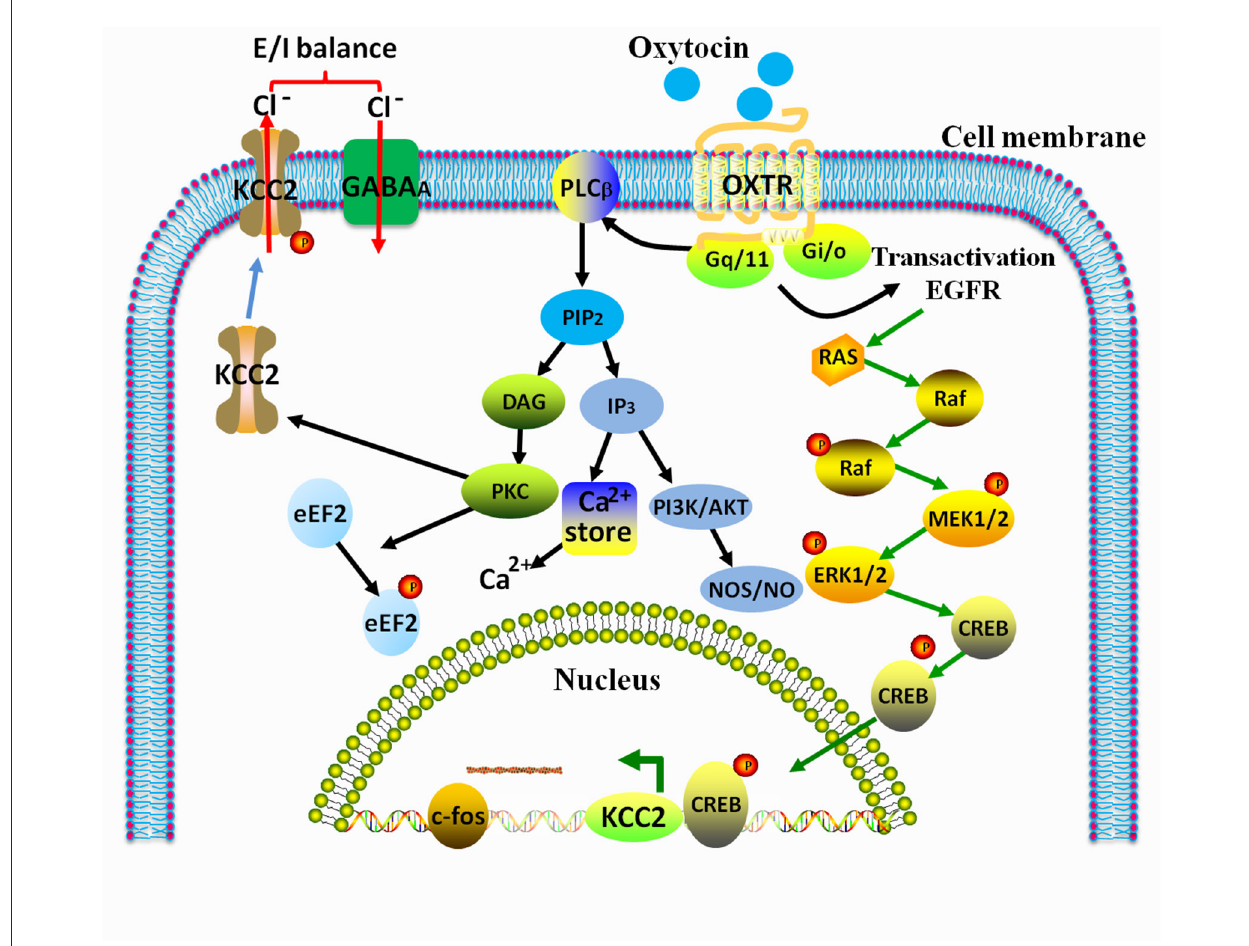
FIGURE4 Relevant signaling pathways of OXT/OXTR in the central nervous system regulate gene transcription and expression and induce LTP, E/I balance, and behavioral responses (Busnelli and Chini, 2018). E/I excitation/inhibition, PKC protein kinase C, LTP long-term potentiation, eEF2 eukaryotic elongation factor 2, KCC2 K + -Cl − co-transporter 2, PLC β phospholipase C β , ERK1/2 extracellular signal-regulated kinase1/2, MEK1/2 mitogen-activated protein kinase kinase1/2, CREB cAMP response element binding protein, PI3K phosphoinositide (PI)3-kinase, EGFR epidermal growth factor receptor, DAG diacylglycerol, and IP 3 inositol